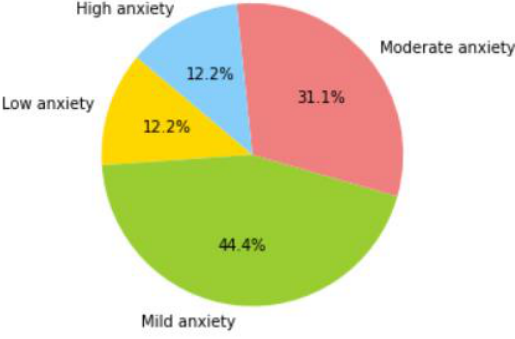
Figure 6. Anxiety class distribution.